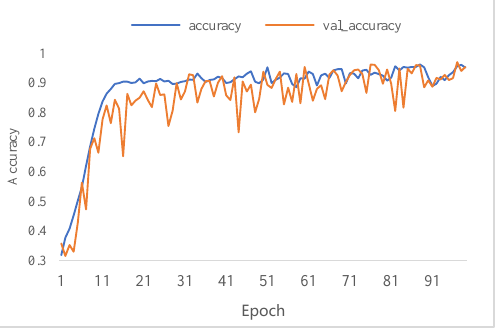
Figure 9. BFPC-Net training set and validation set accuracy.